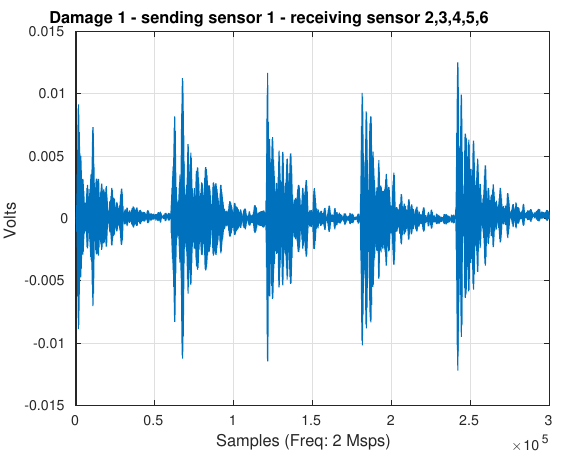
Figure 4. Received signals in the actuation Phase 1 when Damage 1 is performed on the structure.